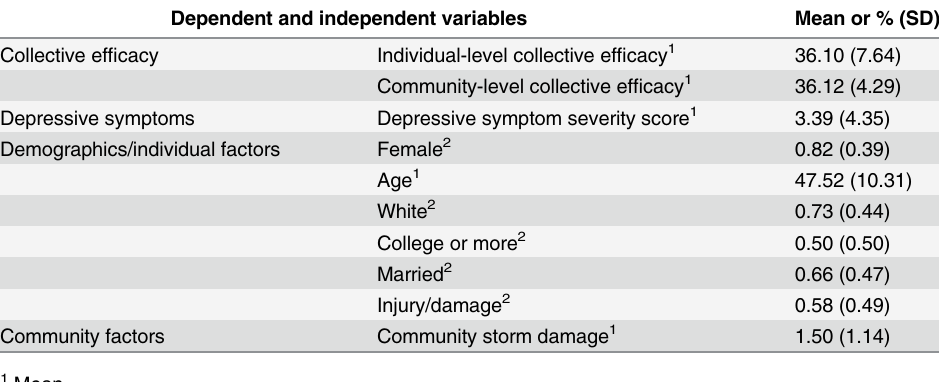
Table 1. Means or proportions with standard deviations for participant characteristics (n =